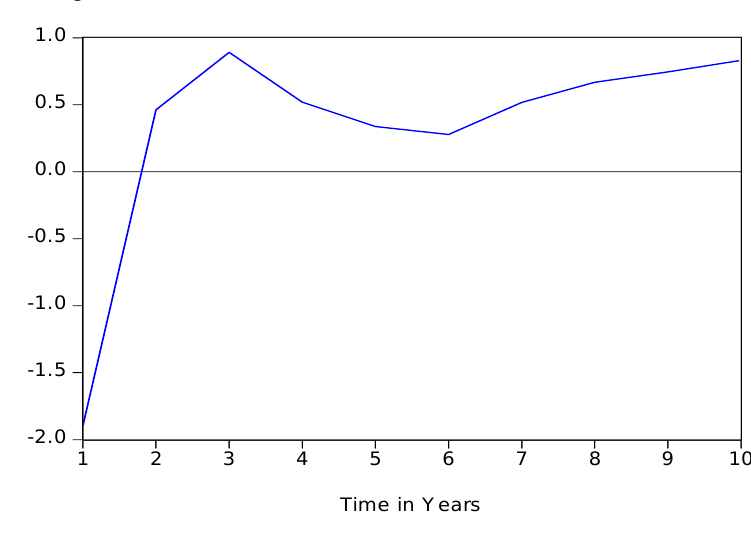
Fig. 3. Accumulated response of the growth rate of non-oil real GDP to development expenditure